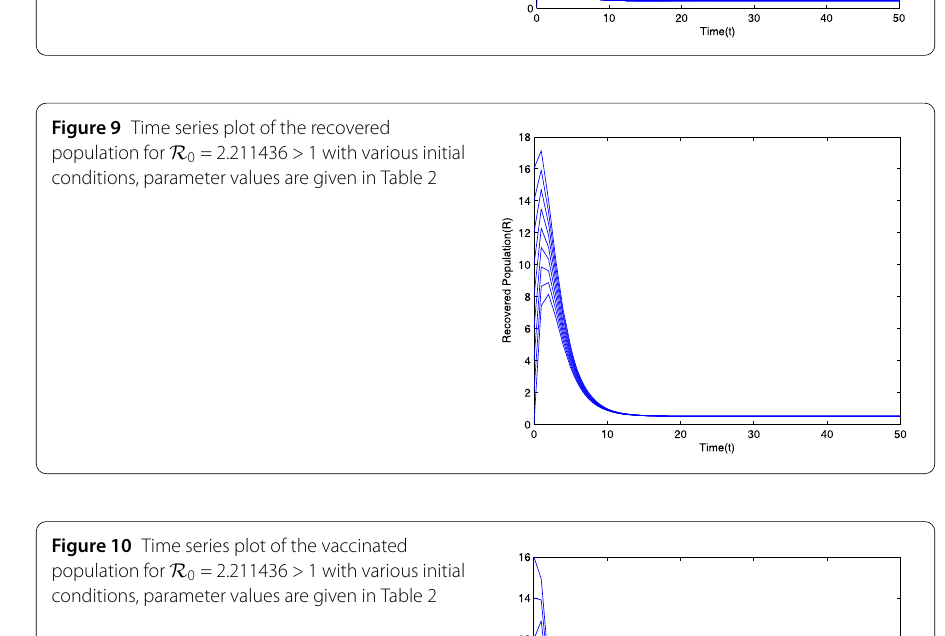
Figure 10 Time series plot of the vaccinated population for R 0 = 2.211436 > 1 with various initial conditions, parameter values are given in Table